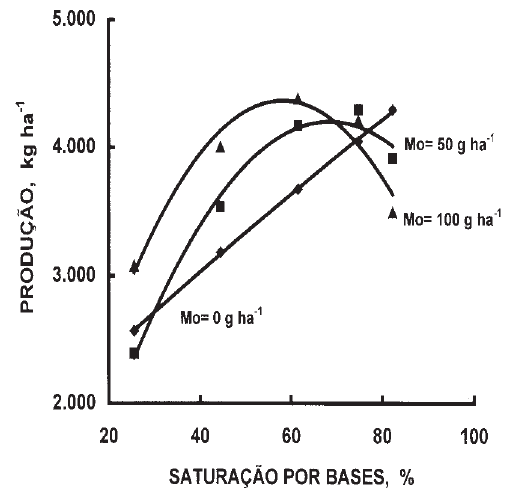
Figura 3. Respostas do sorgo granífero (híbrido DK